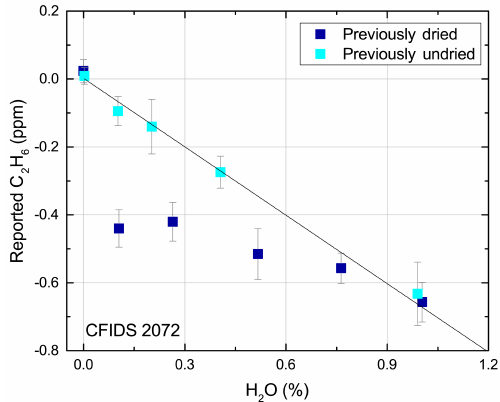
Figure 3. An example of the results from a H 2 O interference ex- periment spanning the range 0–1% H 2 O. The reported C 2 H 6 is al- tered due to the addition of water vapour when measuring zero air (<1ppbC 2 H 6 ) . Dark and light blue markers signify the response when dried and undried ambient air have been measured overnight by the instrument prior to the experiment respectively. Error bars signify the standard deviation of each